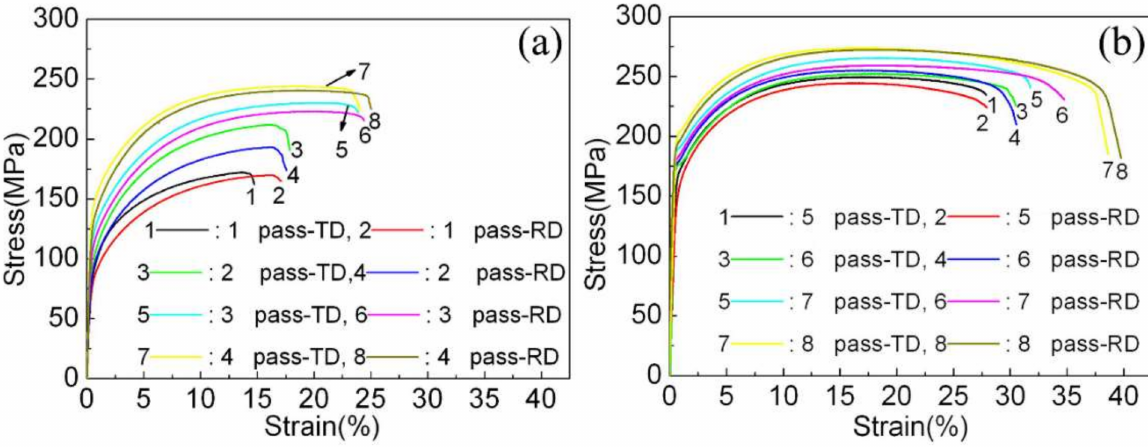
Figure 8. Room temperature stress–strain curves of AZ31 magnesium alloy sheets along the RD and TD during multi-pass lowered-temperature rolling: ( a ) from 1 pass to 4 pass and ( b ) from 5 pass to 8 pass.